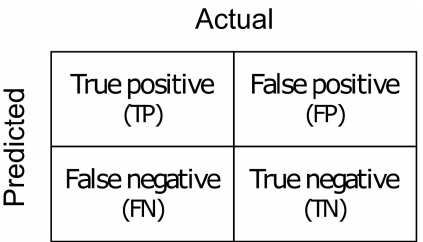
Figure 4. Confusion matrix showing the probability values inherent in the general framework for model